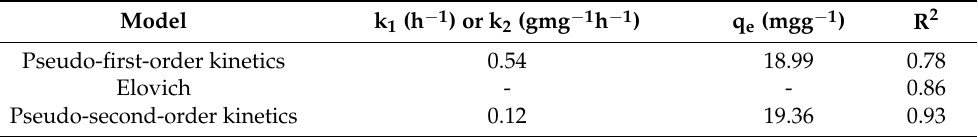
Table 2. MBK Phosphate adsorption Kinetic parameters.